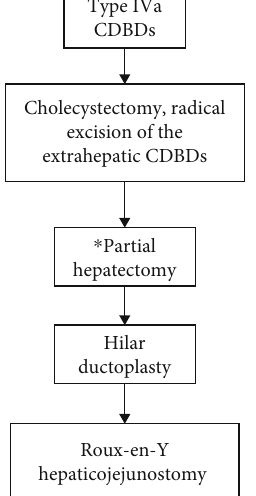
Figure 4: Flow chart of surgical treatment for type IVa CDBDs. ∗ If the proper fl ow of intrahepatic bile duct can be achieved through hilar ductoplasty, partial hepatectomy can be